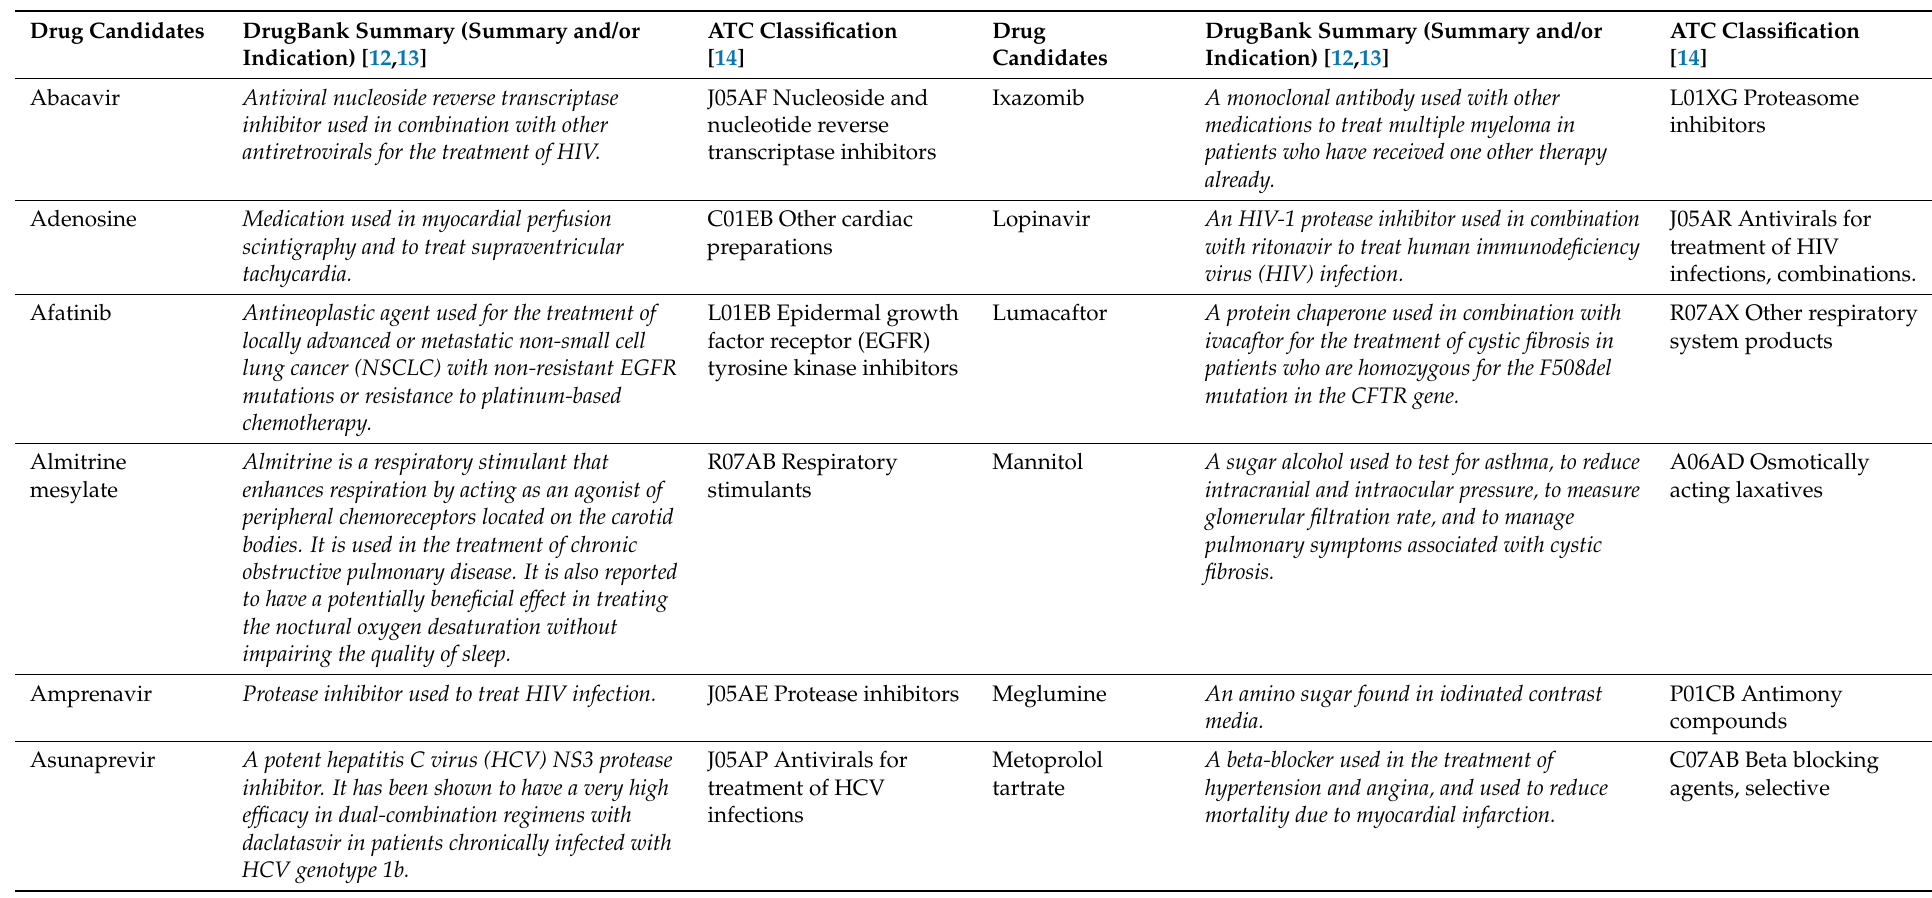
Table A1. Top-ranked promising candidate drug(s)/molecule(s) COVID-2019 that were identified through AI in Kaushal et al. (2020)